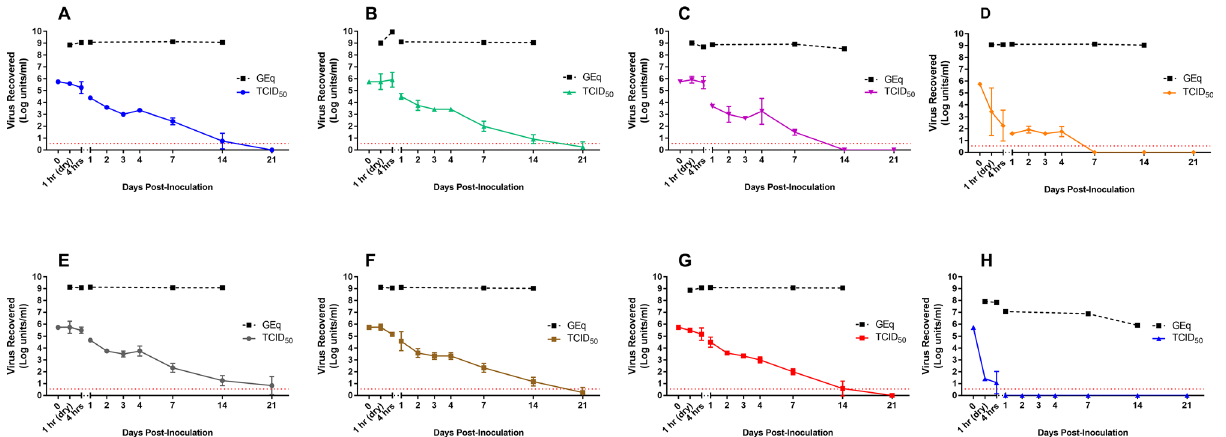
Figure 1. Persistence of SARS-CoV-2 on experimentally inoculated surfaces. Materials from eight experimental surfaces, including ( A ) stainless steel, ( B ) plastic, ( C ) nitrile gloves, ( D ) chemical gloves, ( E ) N95 mask, ( F ) N100 mask, ( G ) Tyvek, and ( H ) cotton were inoculated with 10 µl of SARS-CoV-2 (titre = 7.88 LogTCID 50 / mL) in a tripartite soil load and sampled at predetermined intervals over a 21 day time-course. TCID 50 values (solid lines) represent mean ± SD of viable virus recovered from three biological replicates following end-point titration in Vero E6 cells. Genome equivalents (dashed black lines) are based on nucleoprotein-specific qRT- PCR results obtained from pooled eluates of three biological replicates at indicated sampling points. Red dashed lines indicate limits of quantification for the TCID 50